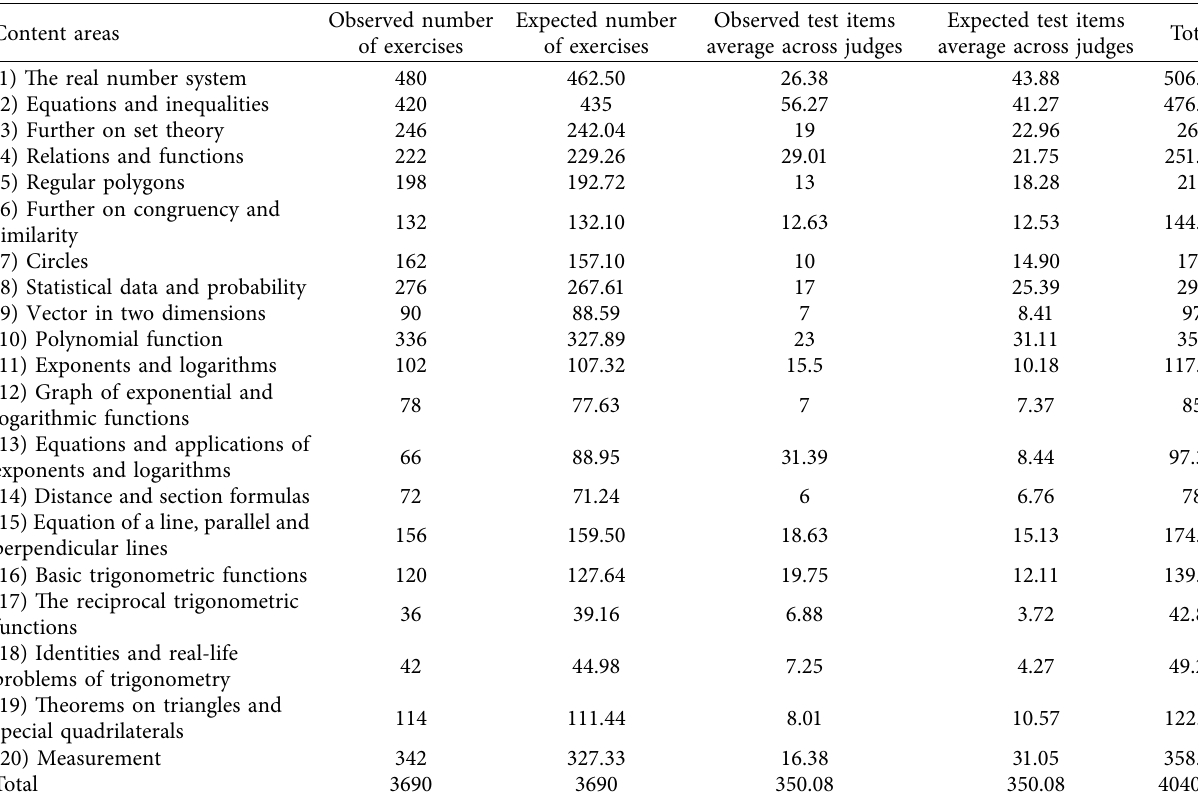
Table 4: The number of observed and expected tests items that are determined from the contents of the syllabus exercises by judges. Content